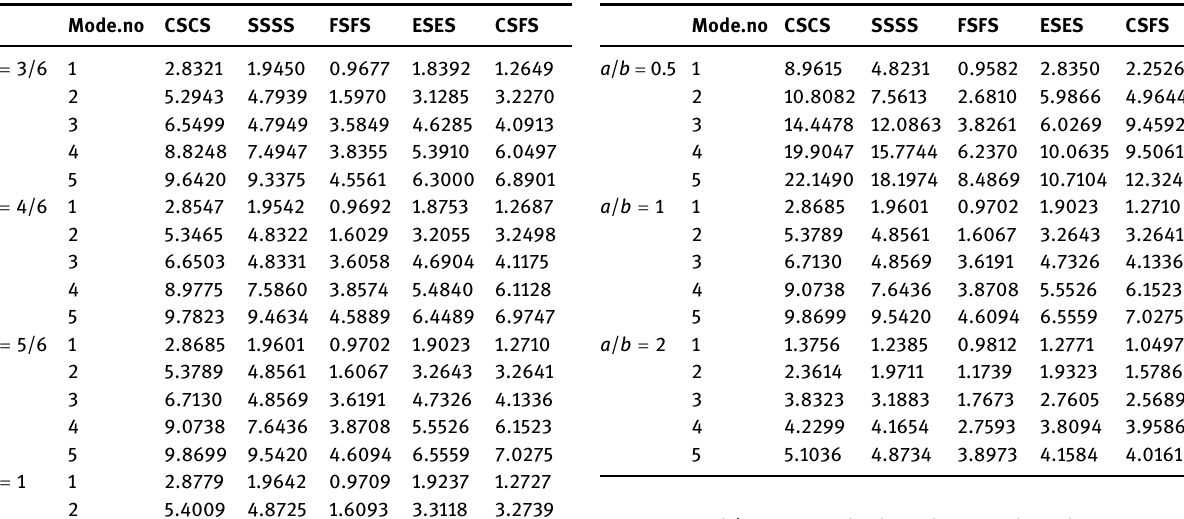
Table 3: Nondimensional frequency parameters of rectangular plate